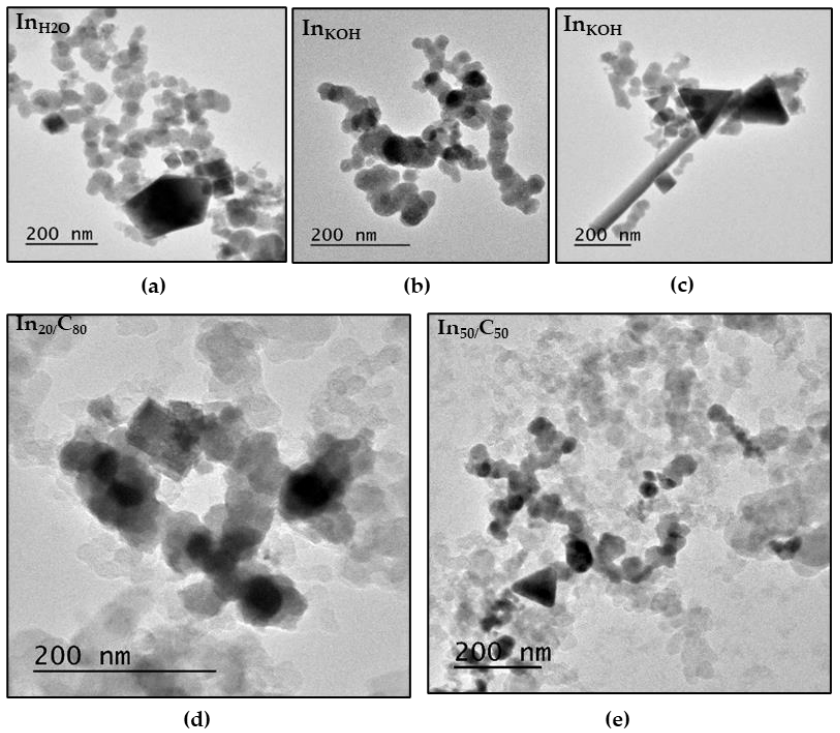
Figure 3. Structural analysis of the nanoparticles by TEM: ( a ) In NPs washed with H 2 O; ( b , c ) In NPs washed with KOH; ( d ) In over carbon with a ratio of 20/80 wt. %. ( e ) In over carbon with a ratio of 50/50 wt. %.